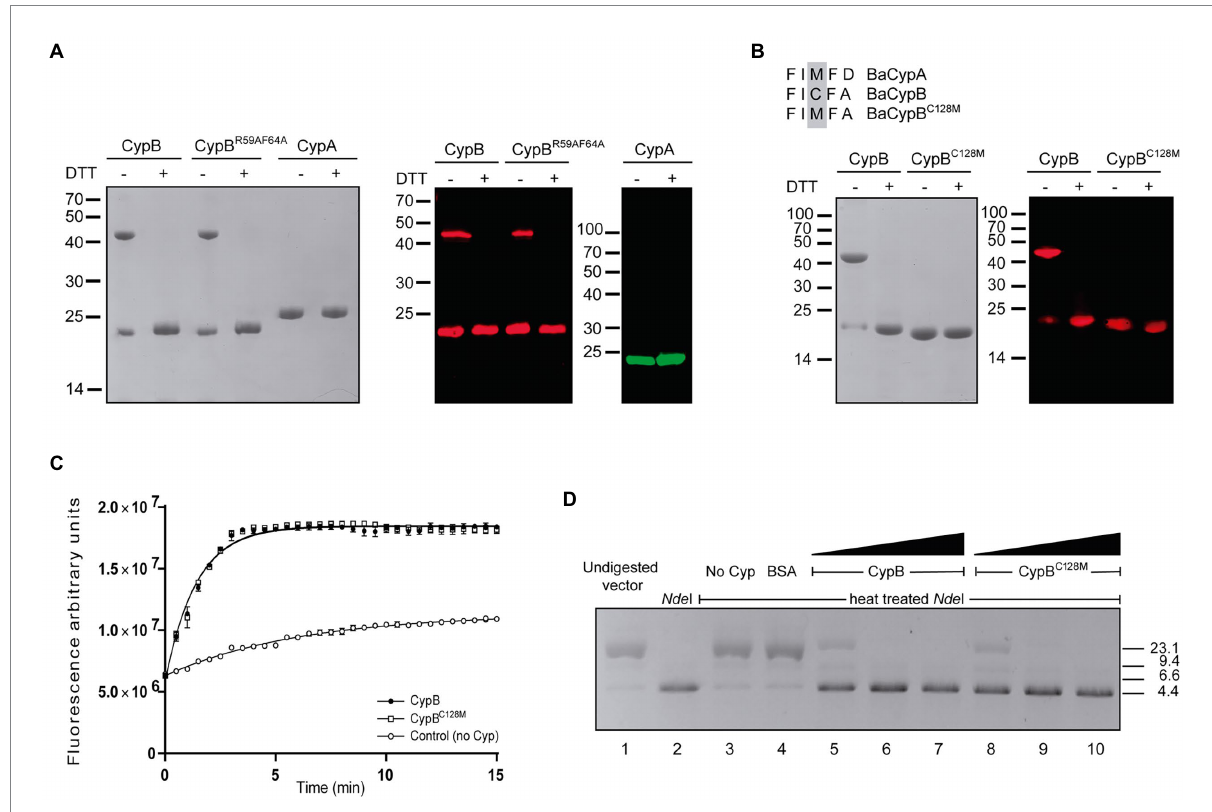
FIGURE 7 CypB is a homodimeric protein. Coomassie blue staining and Western blot analysis of protein samples incubated in the presence or absence of DTT. (A) CypB, CypB R59A/F64A , CypA, (B) CypB and CypB C128M . (C) GFP PPIase activity assay with 2 μ M of CypB, CypB C128M , or without CypB. (D) Enzymatic activity of thermal-denatured Nde 1 (53.8 ° C for 20 min) in the presence of CypB, CypB C128M , or control protein BSA. Lane 1, uncut pET28 plasmid; Lane 2, pET28 plasmid incubated with native Nde I; Lane 3, pET28 plasmid incubated with heat-inactivated Nde I; Lane 4, pET28 plasmid incubated with heat-inactivated Nde I in the presence of BSA (5 μ g), Lane 5, 6, and 7, pET28 plasmid incubated with heat-inactivated Nde I in the presence of increasing concentrations of CypB protein (1, 2.5, and 5 μ g); Lane 8, 9, and 10, pET28 plasmid incubated with heat-inactivated Nde I in the presence of increasing concentrations of CypB C128M protein (1, 2.5, and 5 μ g). The results are representative of three independent